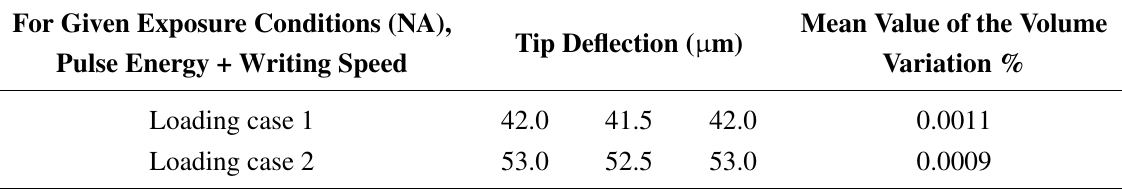
Figure 8. ( a ) Method for measuring laser-induced volume variation in fused silica using cantilever deflection. The laser exposure takes place only near the anchoring point of the cantilever and only in its upper-half thickness and forms a bimorph composite structure that induces local bending of the cantilever. The deflection measured at the tip of the cantilever is effectively amplified by the length of the cantilever. The two different configurations result to different absolute values of induced volume variations, due to the spherical aberration effect. ( b ) A sketch map of focusing across a plane surface from air into the sample. O 1 is the crossing point of the light axis across the interface, F 0 is the geometrical focus in air, F 1 is the focus under the paraxial approximation, f d = | O 1 F 1 | = n | O 1 F 0 | is the focusing depth, F 3 is the focus of the marginal rays, and Δ = | F 1 F 3 | is the foci range (focal displacement). Table 2. Volume variation measured using the microcantilevers bending method. Three cantilevers were measured.